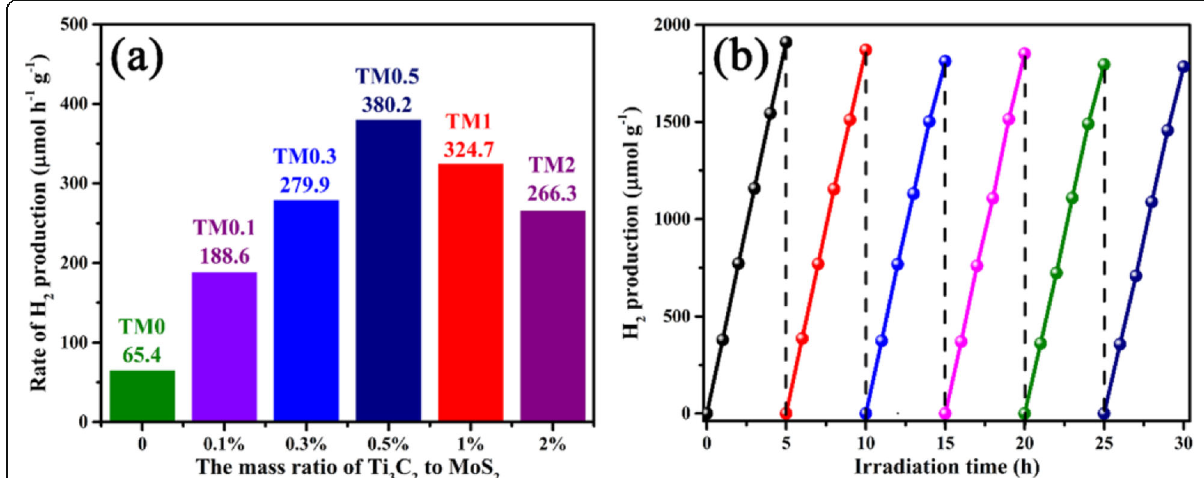
Fig. 8 a The photocatalytic hydrogen evolution rate of TM0, TM0.1, TM0.3, TM0.5, TM1 and TM2 samples under visible light irradiation. b The recycling tests of TM0.5 for water splitting process